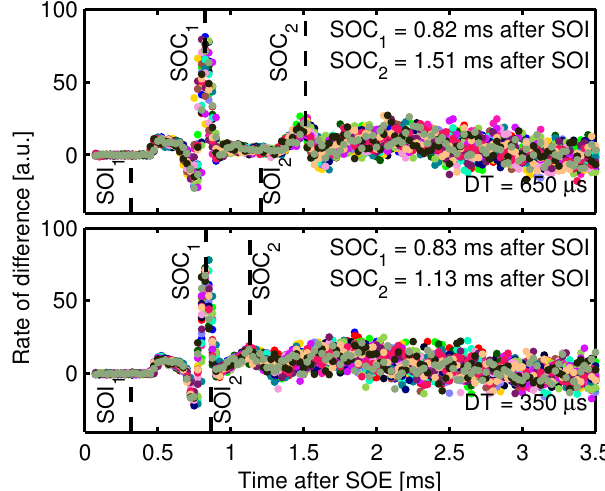
Figure 7. Example of the rate of difference represented by a different color for each cycle. Vertical dashed lines represent either SOI or start of combustion (SOC). Results are for a rail pressure of 100MPa, a chamber density of 22.8kgm − 3 , and temperature of